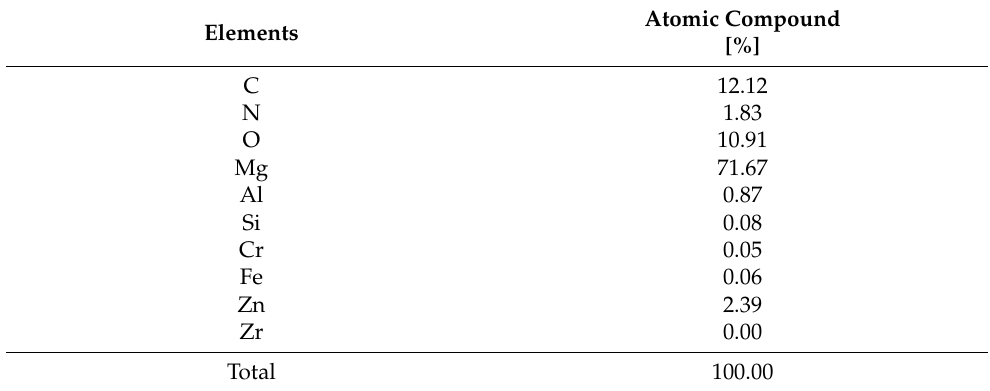
Table 6. General EDX analyses of the image shown in Figure